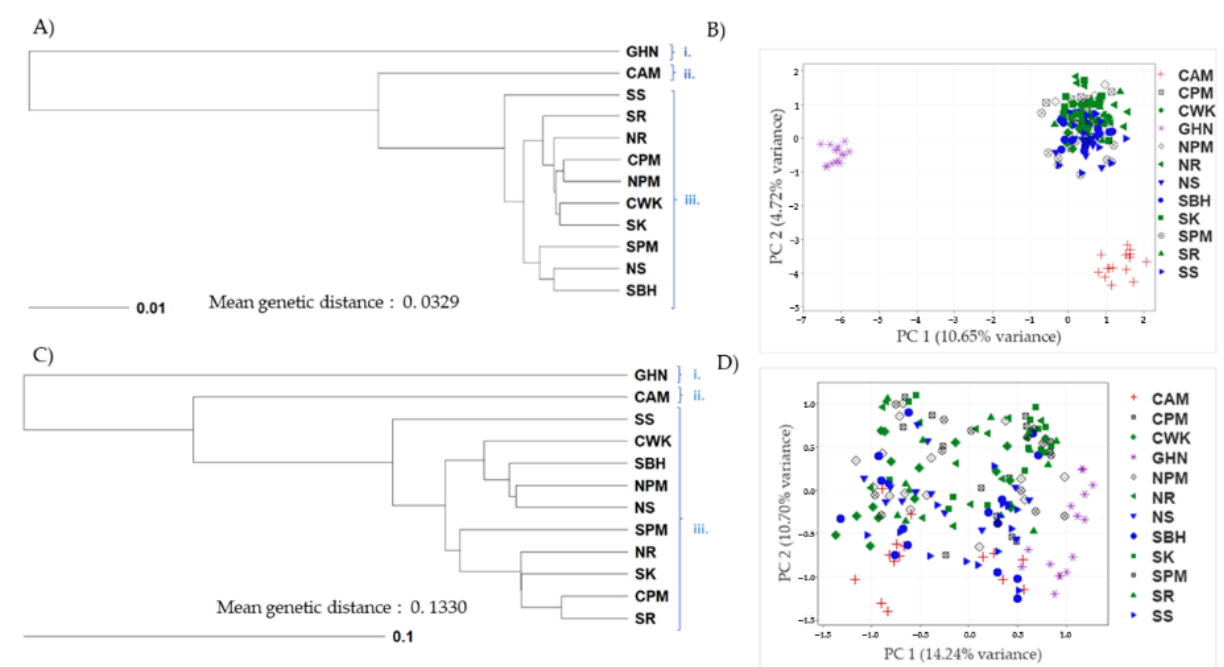
Figure 2. Phenogram and genetic clustering of 180 E. kamerunicus collected from 12 populations using ( A and B ) 220 SNP and ( C and D ) 8 SSR. Both SNP and SSR mutually assigned the assayed 12 populations into 3 major divisions (2 lineages and 1 cluster): (i) GHN, (ii) CAM, and (iii) introduced populations in Malaysia and Indonesia. GHN = Ghana, CAM = Cameroon, SS = South Sarawak, SR = South Riau, NR = North Riau, CPM = Central Peninsular Malaysia, NPM = North Peninsular Malaysia, CWK = Central West Kalimantan, SK = South Kalimantan, SPM = South Peninsular Malaysia, NS = North Sarawak, SBH = Sabah, East Malaysia.